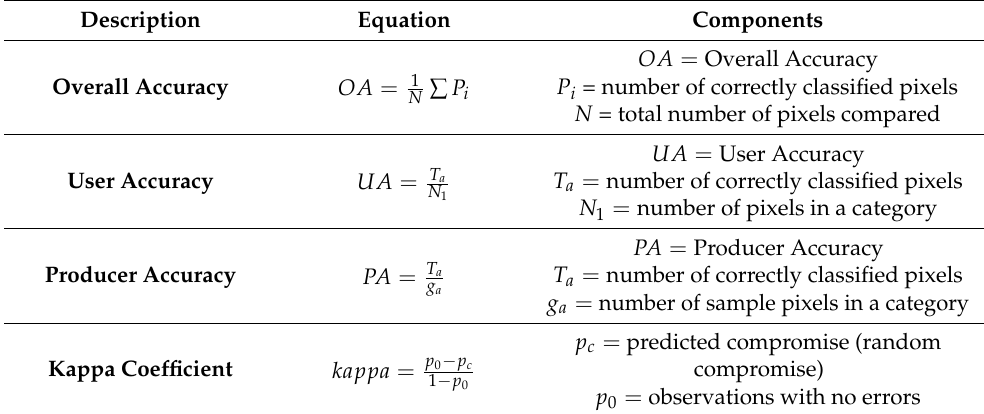
Table 2. Accuracy assessment indices.